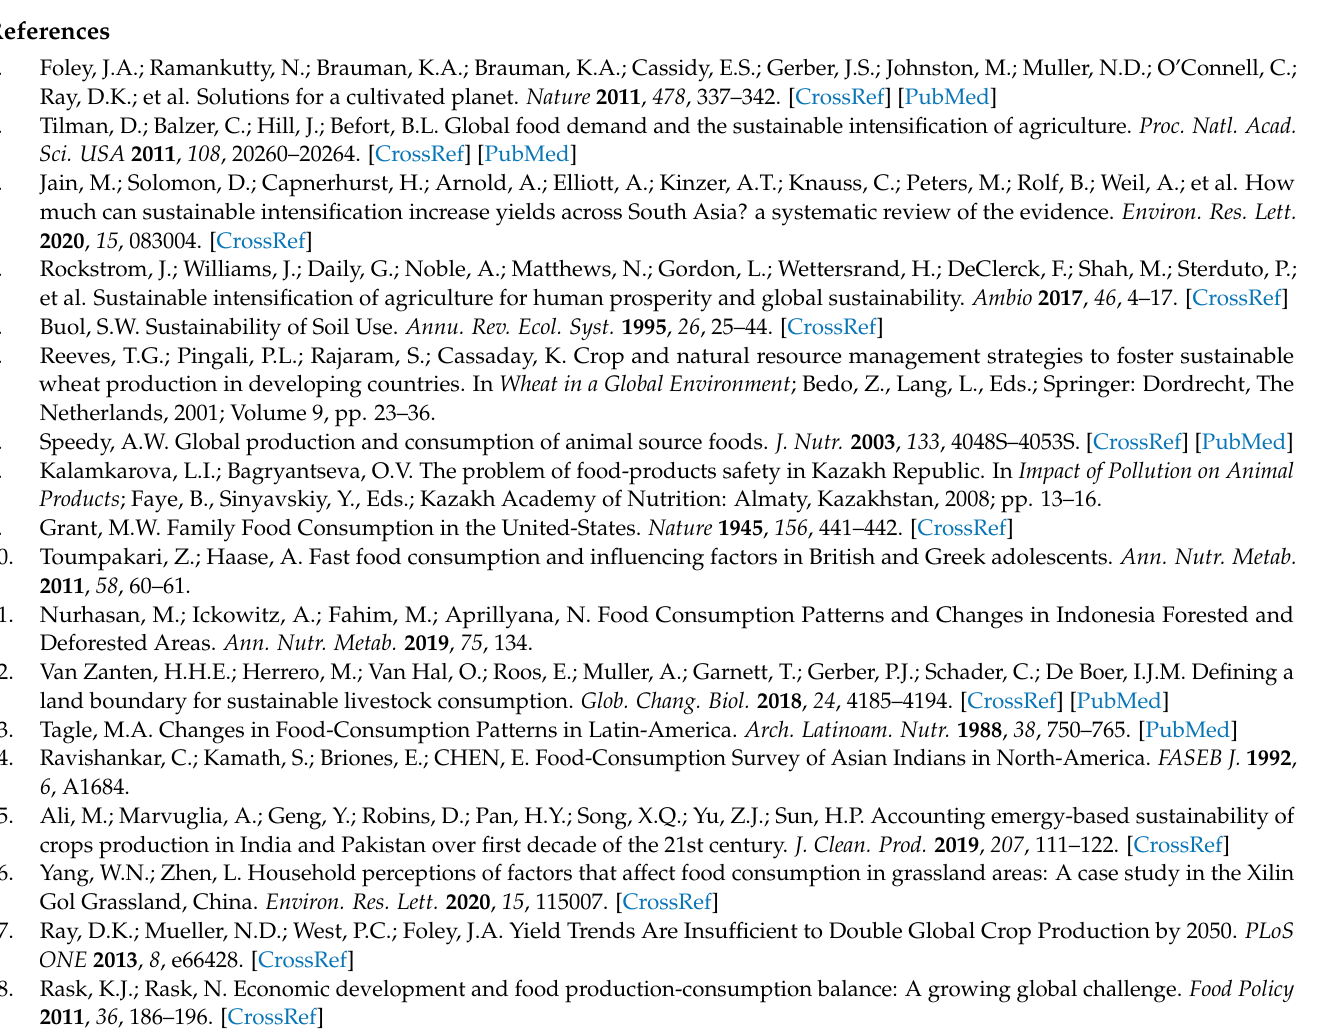
Figure A2. Food import